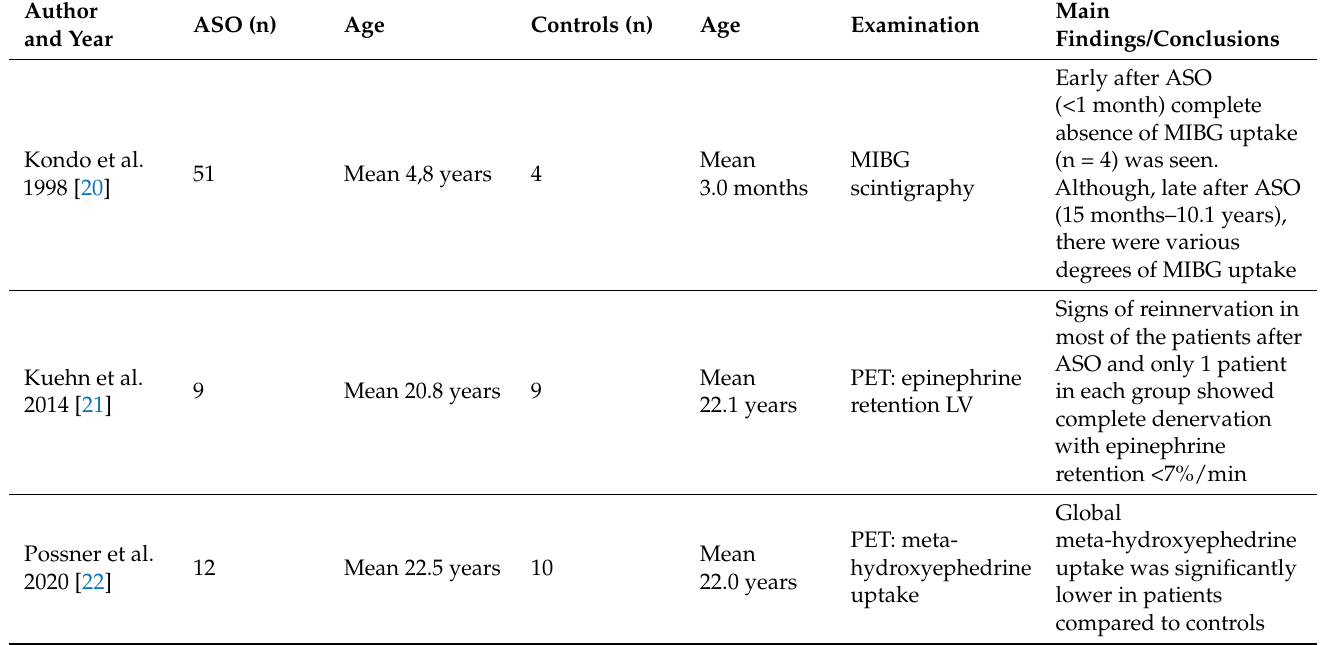
Table 4. Overview innervation studies after arterial switch